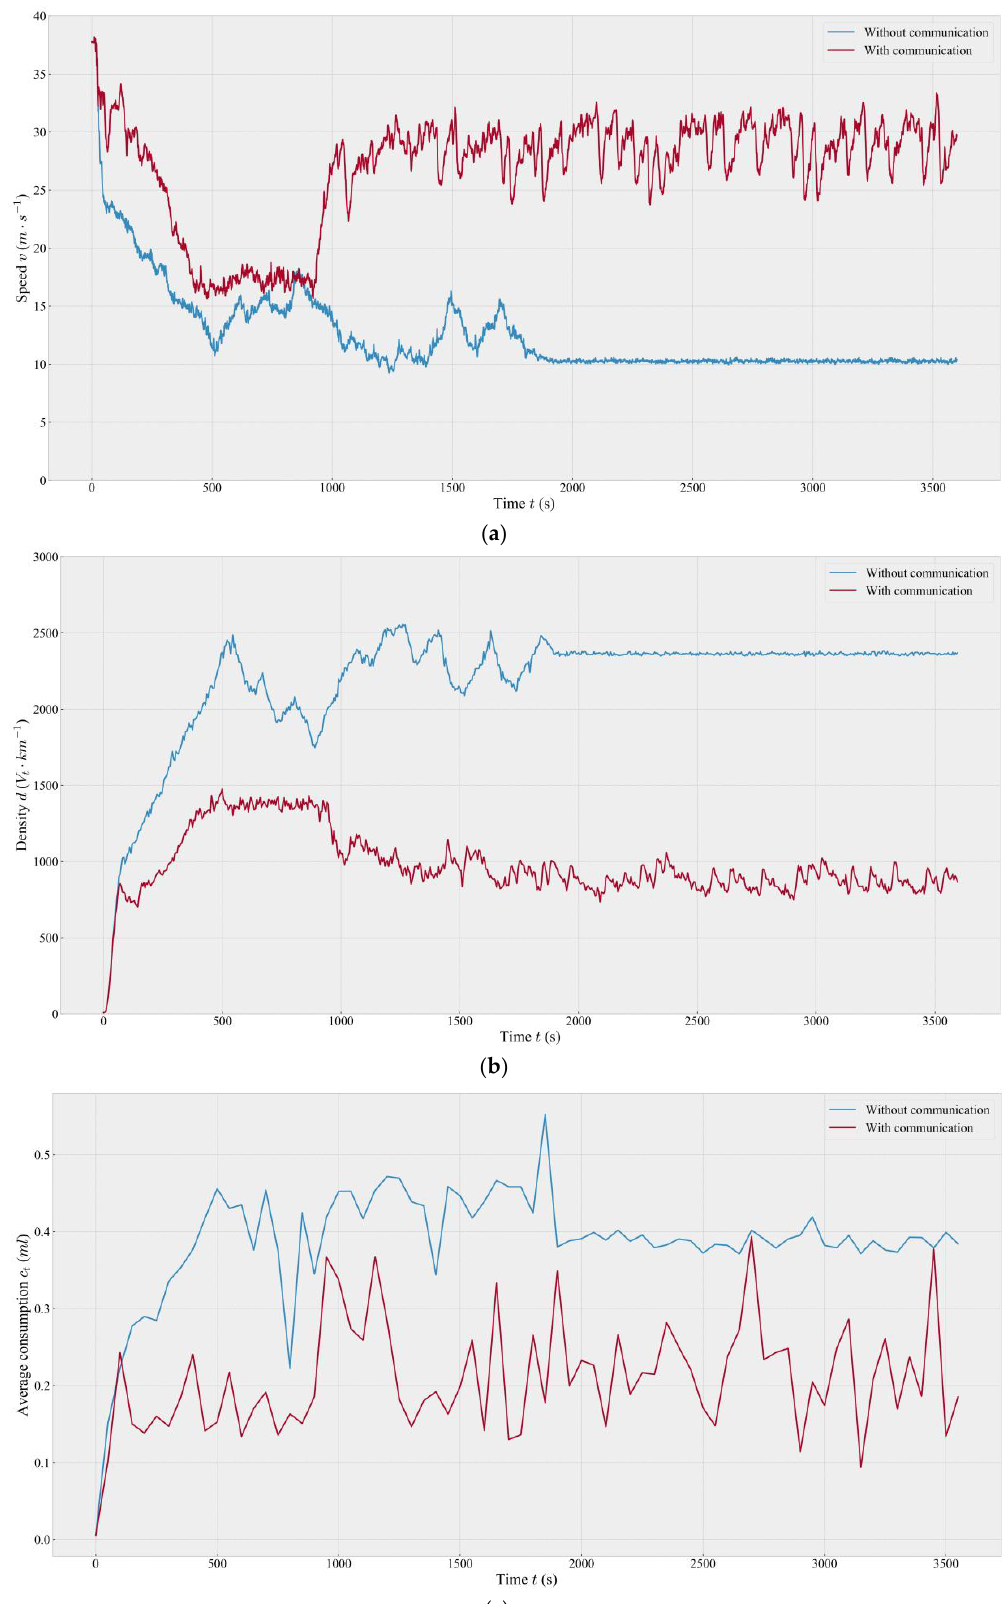
Figure 12. Simulation with 1500 vehicles/hour per lane. ( a ) Average speed; ( b ) Traffic density, and ( c ) Average consumption.